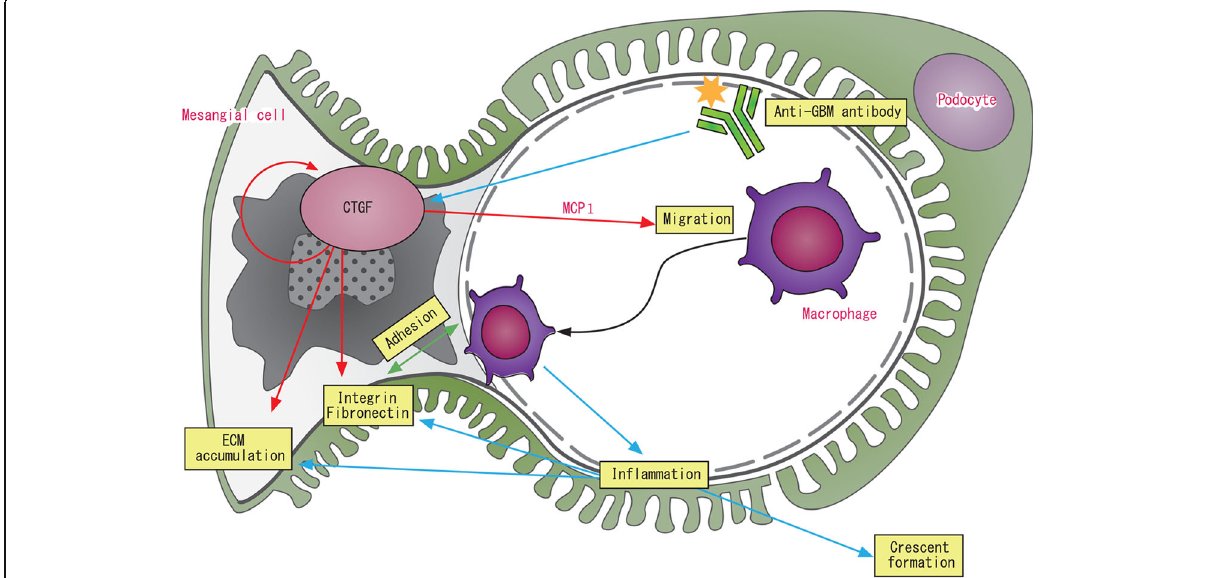
Fig. 3 CTGF mediates chemotaxis and adhesion of macrophages as well as ECM production in mesangial cells. Anti-GBM nephritis elicits upregulation of CTGF in mesangial cells. CTGF derived from mesangial cells increases MCP-1 (CCL2) expression, which induces macrophage migration and ECM proteins, including integrin α v and fibronectin, which contribute macrophage adhesion with mesangial